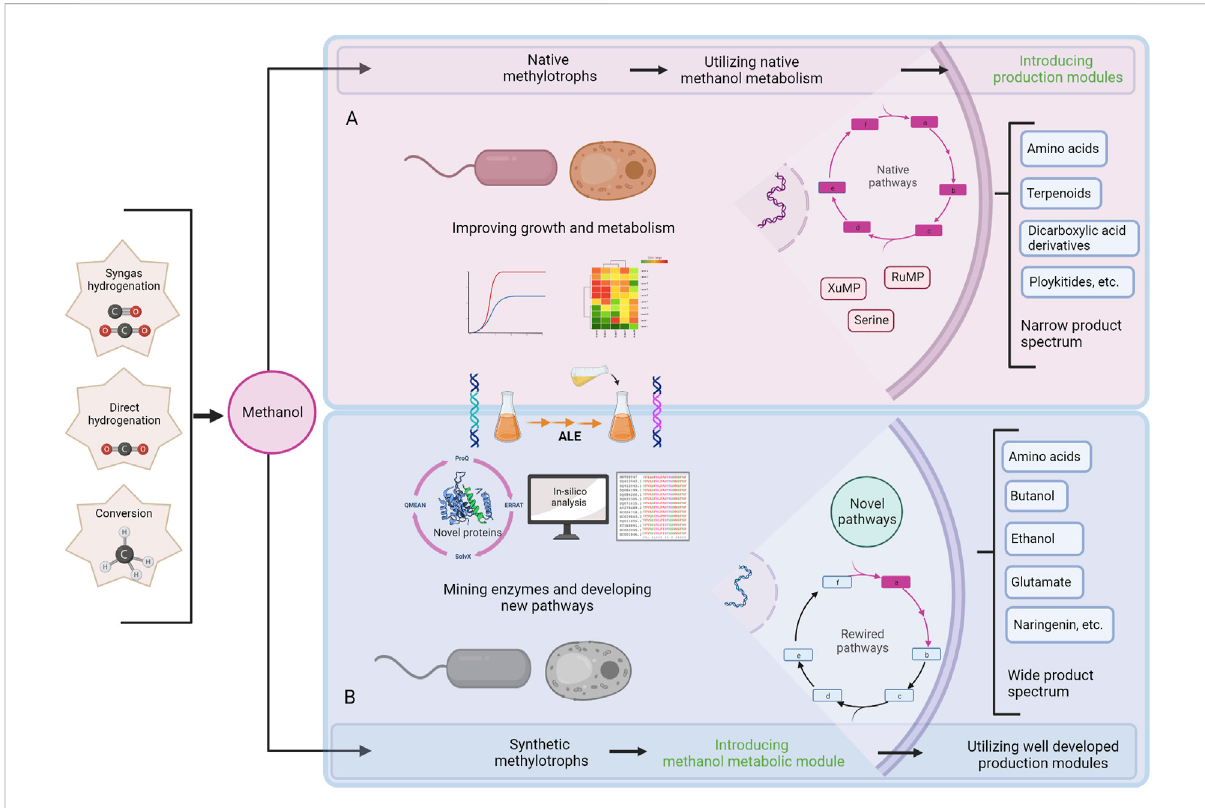
FIGURE 1 Schematic summary of engineering native and synthetic methylotrophs. (A) Engineering scheme of native methylotrophs for chemical production from methanol, (B) Engineering scheme of synthetic methylotrophs for chemical production from methanol. ALE; adaptive laboratory